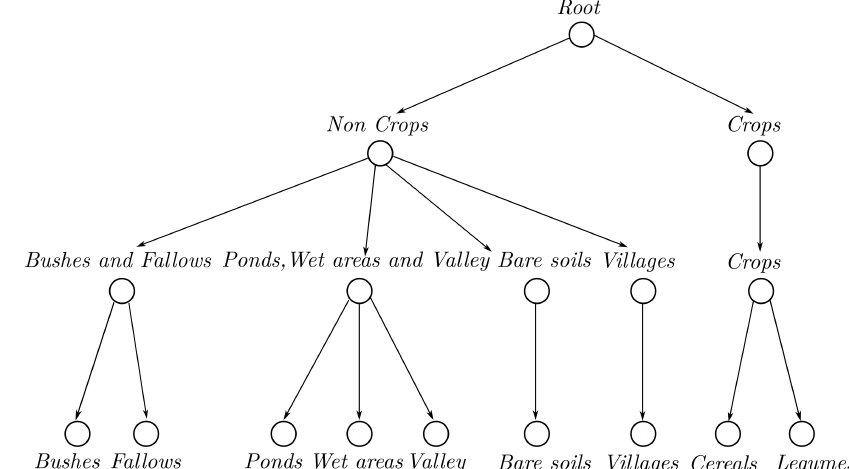
Figure 3. Overview of the taxonomy derived from the Senegalese site land cover